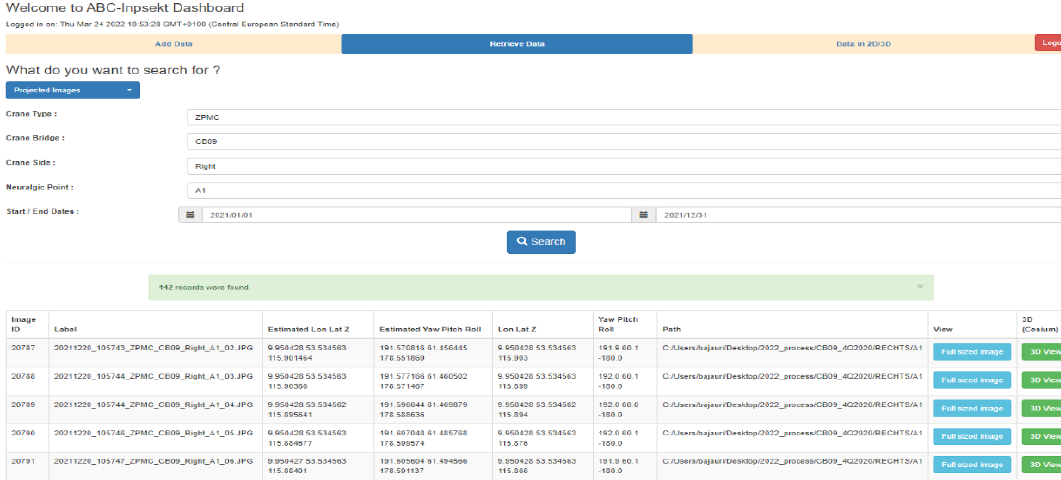
Copyright : Figure 5 showing the crane schematic is provided by HHLA’s Container Terminal Tollerort (CTT) for this research. It may not be used for other purposes or publications without their prior consent.